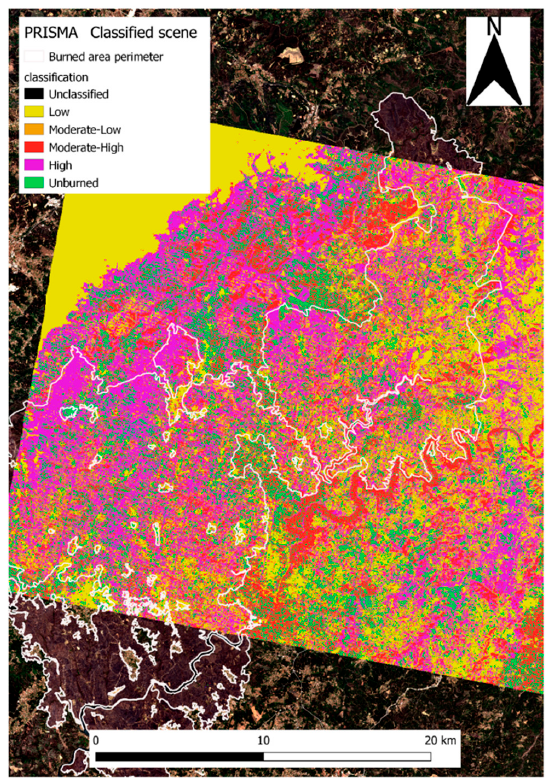
Figure 13. PRISMA image classified based on the RBR severity classes spectral library.